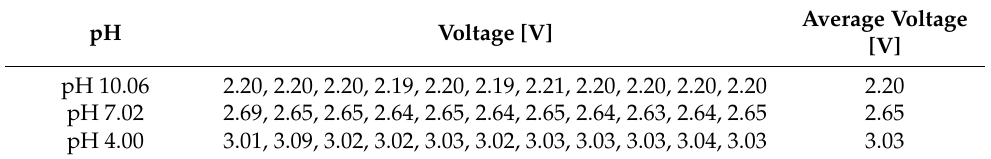
Table 3. Data for pH